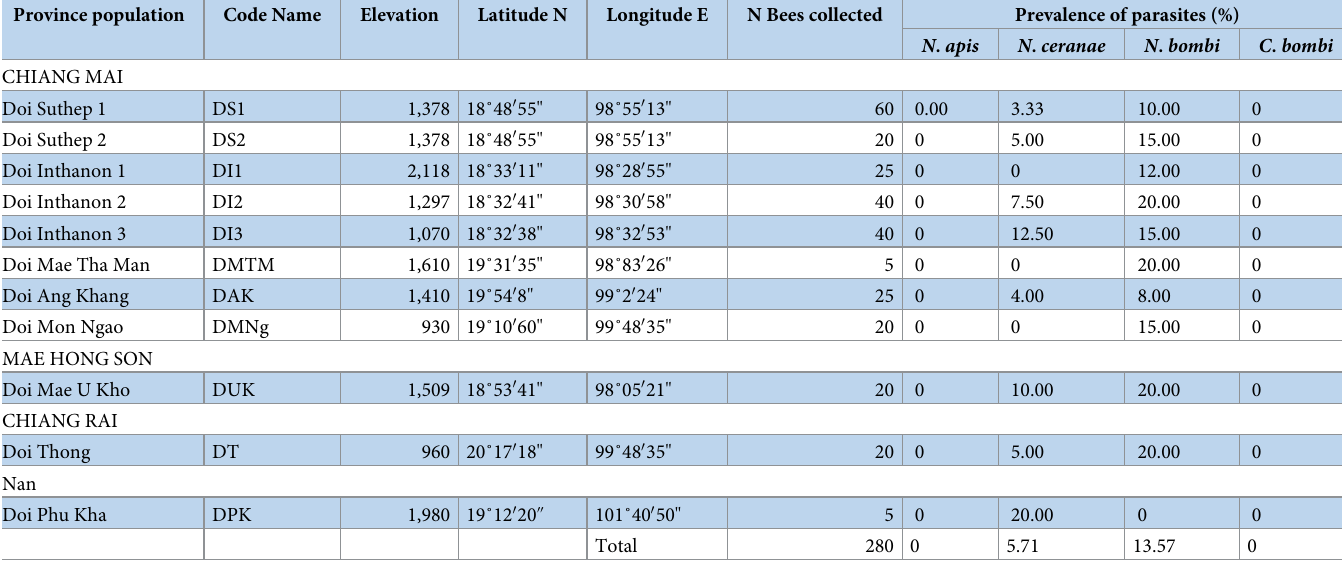
Table 1. Prevalence of four parasites recovered from Bombus species in northern Thailand. Province